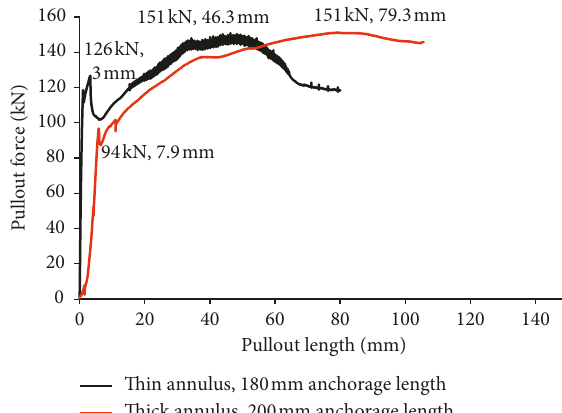
Figure 8: Performance of cable bolts tested with different grout anchorage